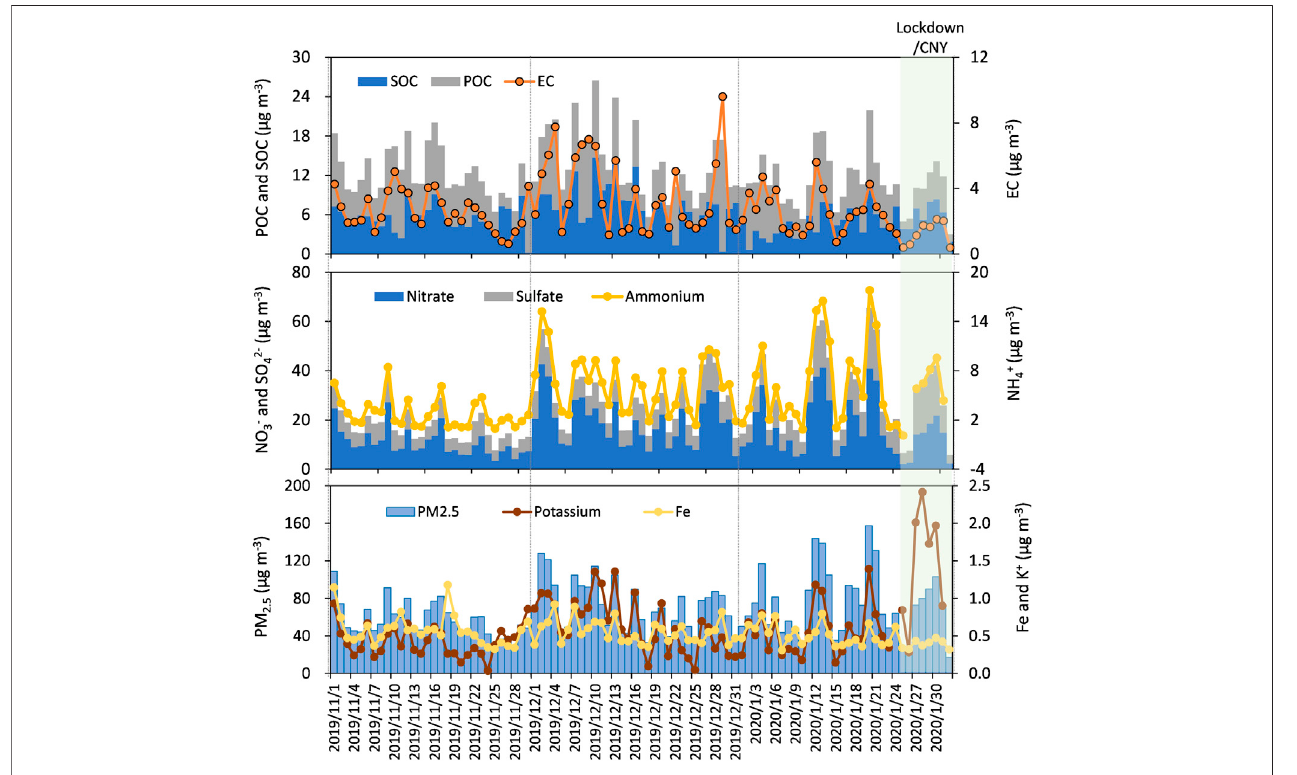
FIGURE 3 | Daily variation of major chemical compositions in PM 2.5 at the sampling